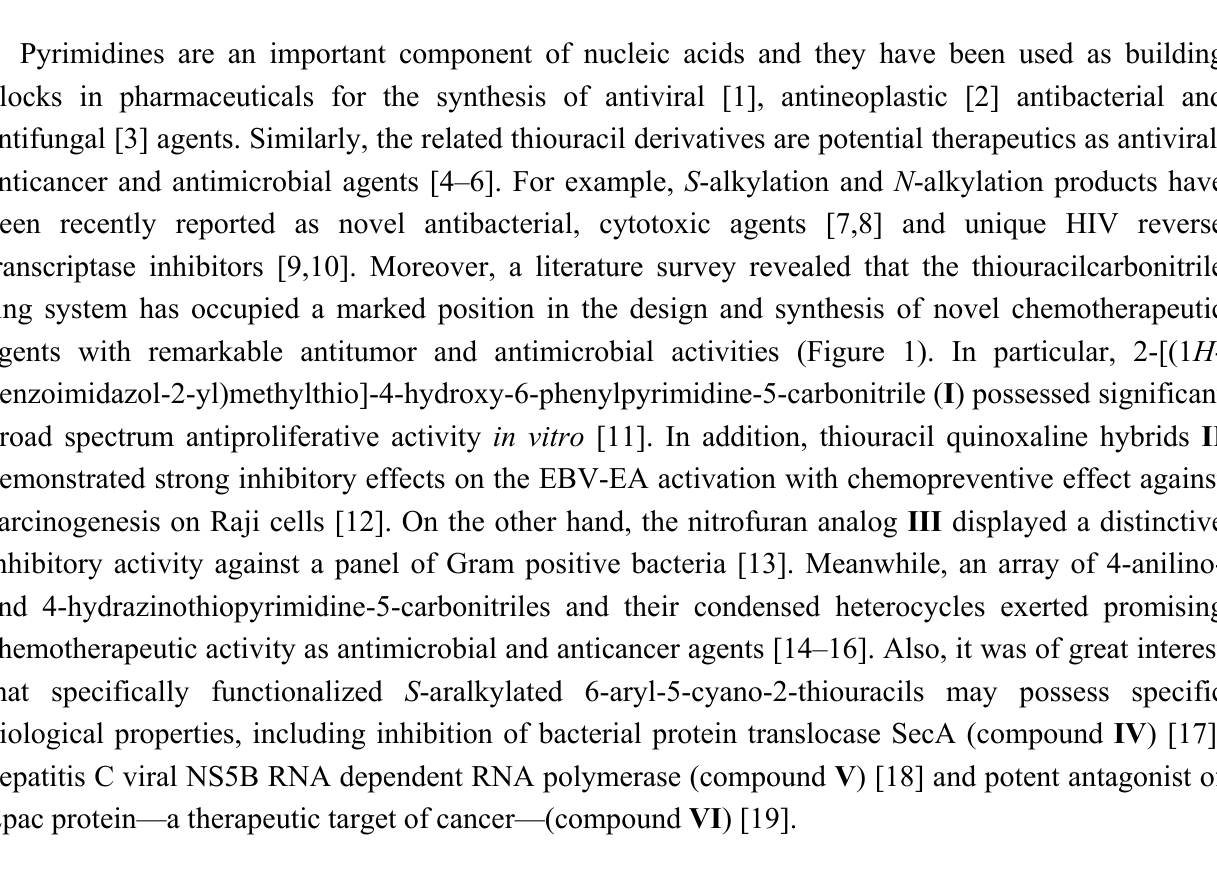
Figure 1. Structures of some potent antimicrobial and anticancer 6-aryl-5-cyano-2-thiouracil lead